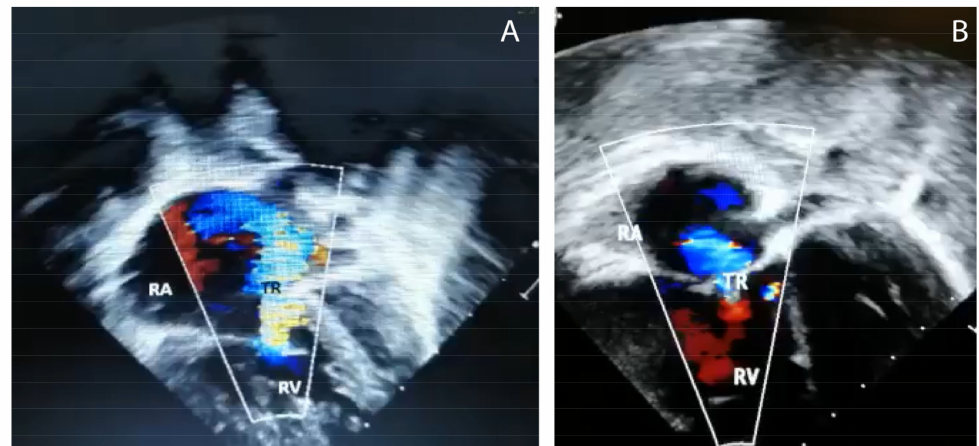
Figure 2. Echocardiography with Doppler images from case # 2 showing ( A ) hypertrophic right ventricle (RV) and dilated right atrium (RA), and ( B ) tricuspid regurgitation